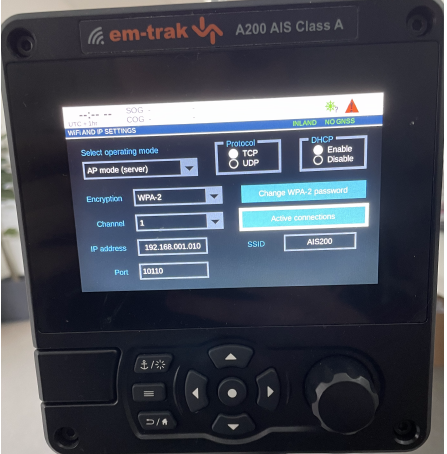
Figure 6. The Wi-Fi settings menu in